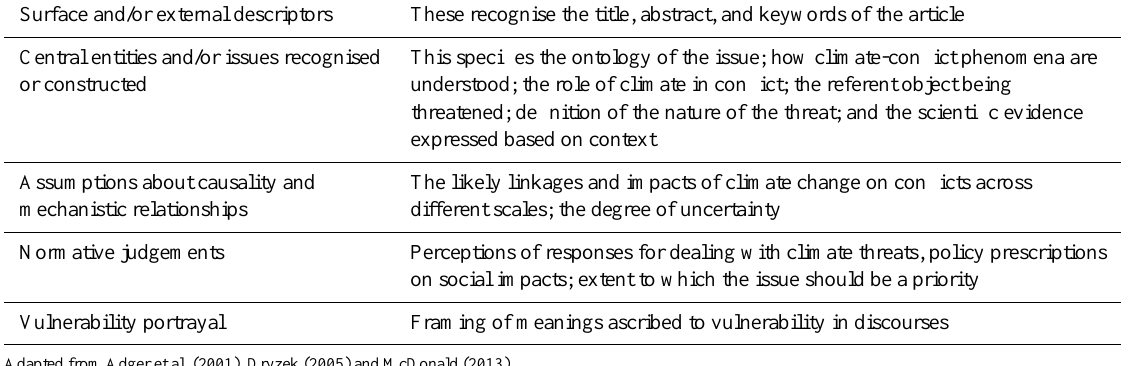
Table 2. Analytical approach for discourse analysis of climate conflict peer-reviewed articles. Surface and/or external descriptors